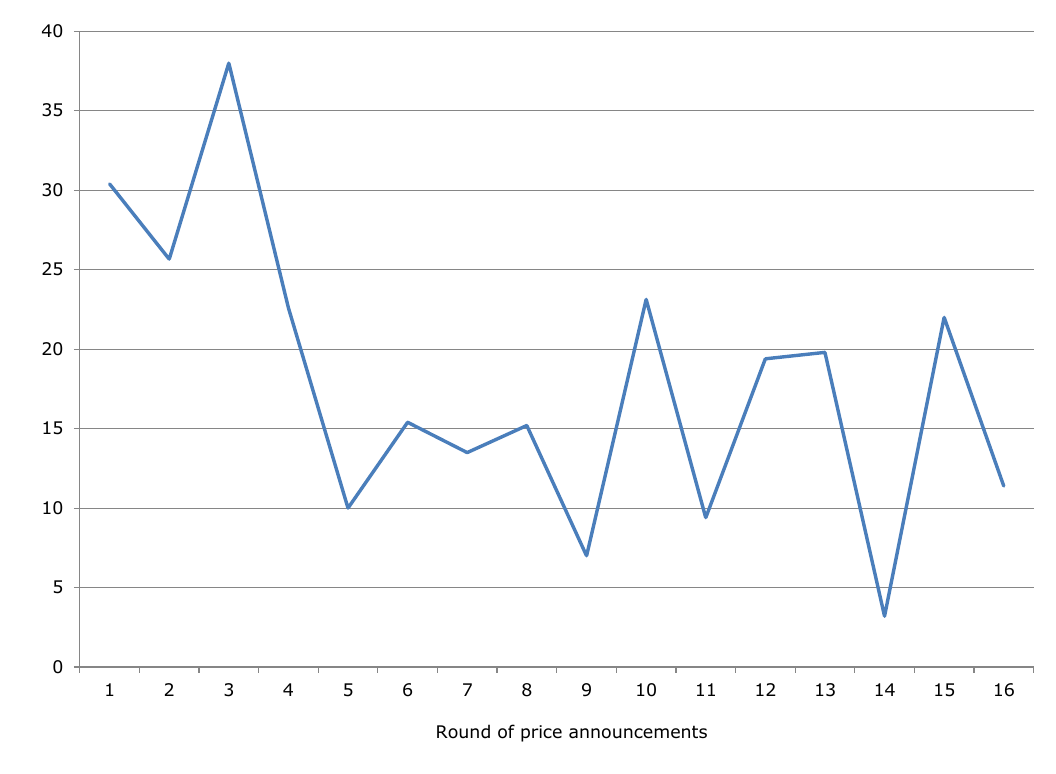
Figure 35: Announced price changes: energy suppliers’ reaction times (in